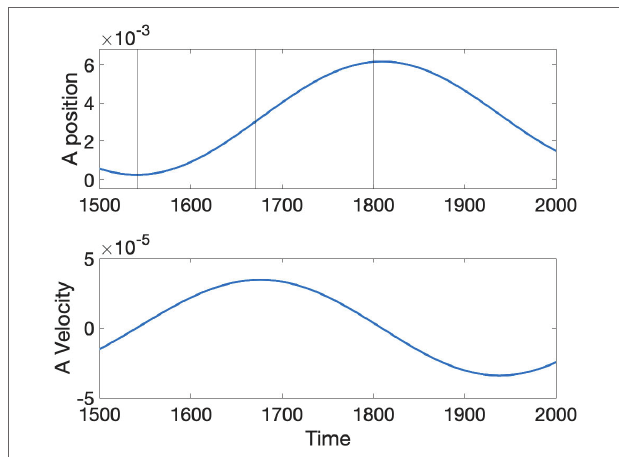
FIGURE 8 | Position and velocity of A predicted by the simultaneous Turing and Hopf pattern of Equation